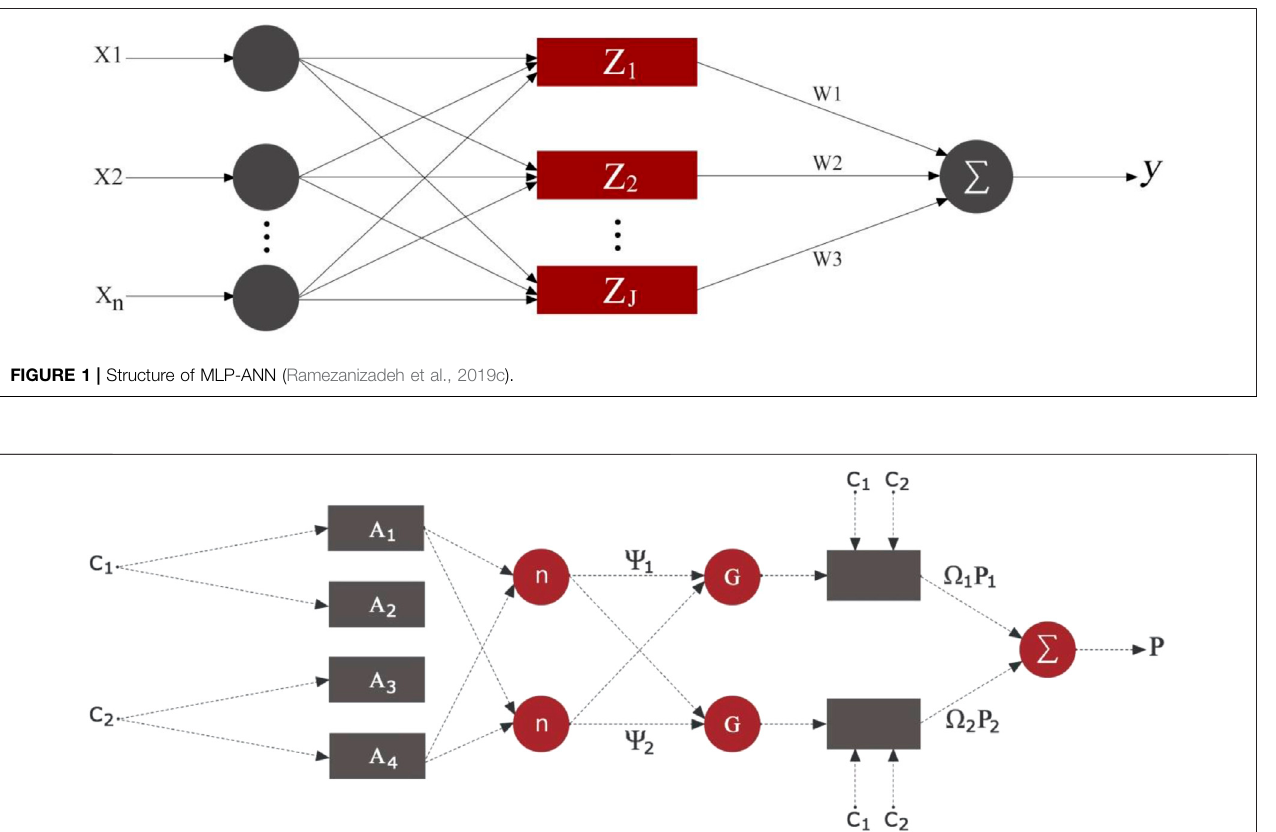
Frontiers in Energy Research |